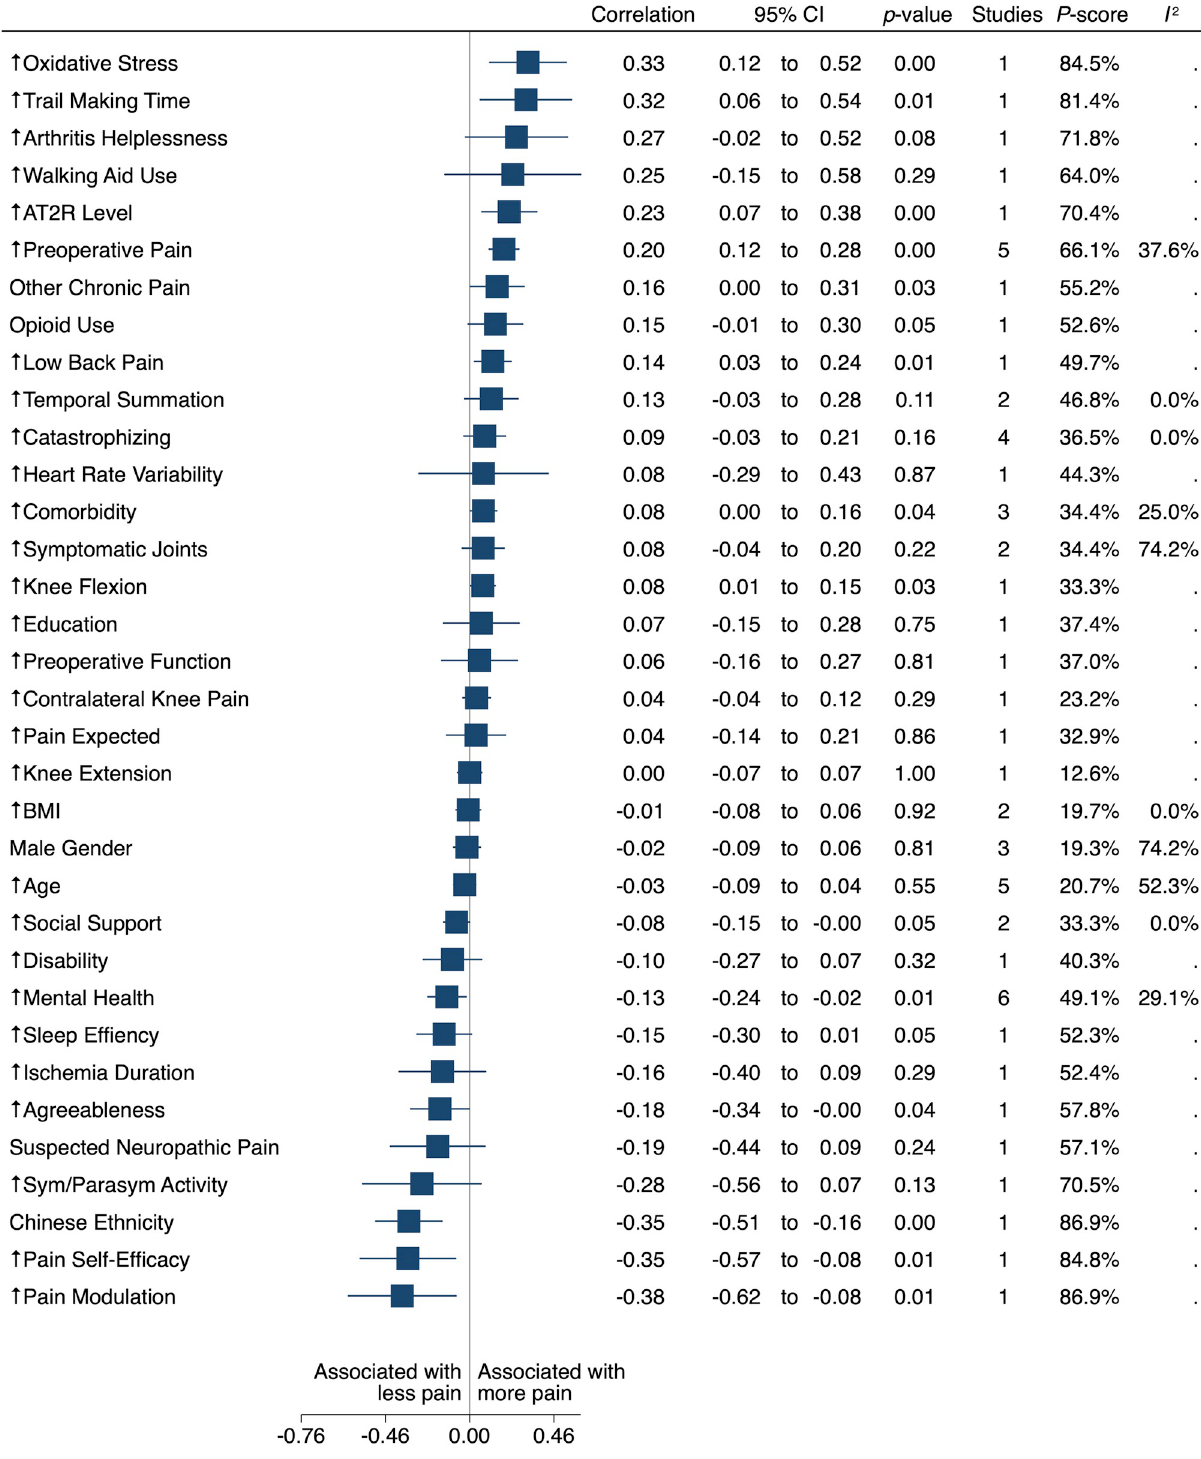
PLOS ONE | https://doi.org/10.1371/journal.pone.0283446 March 24,